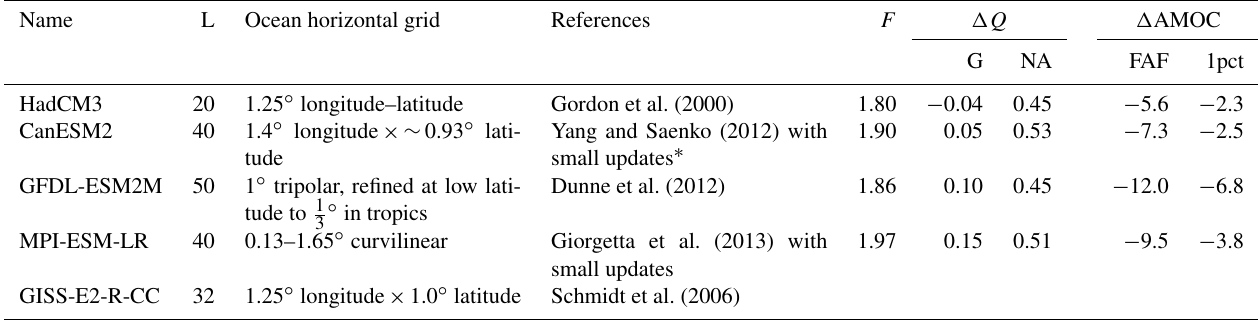
Table 2. AOGCMs used for FAFMIP preliminary